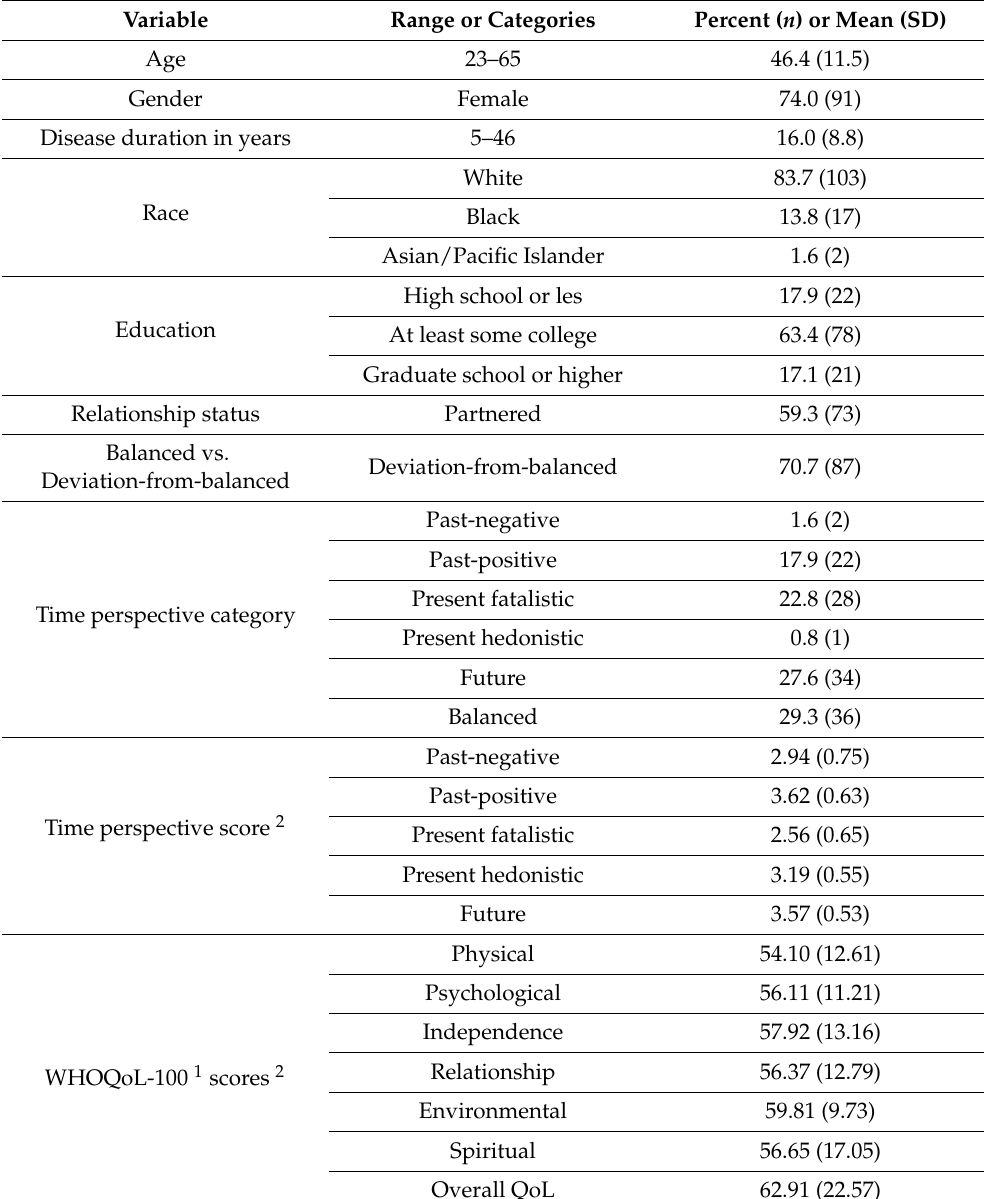
Table 1. Demographic characteristics at baseline ( n =